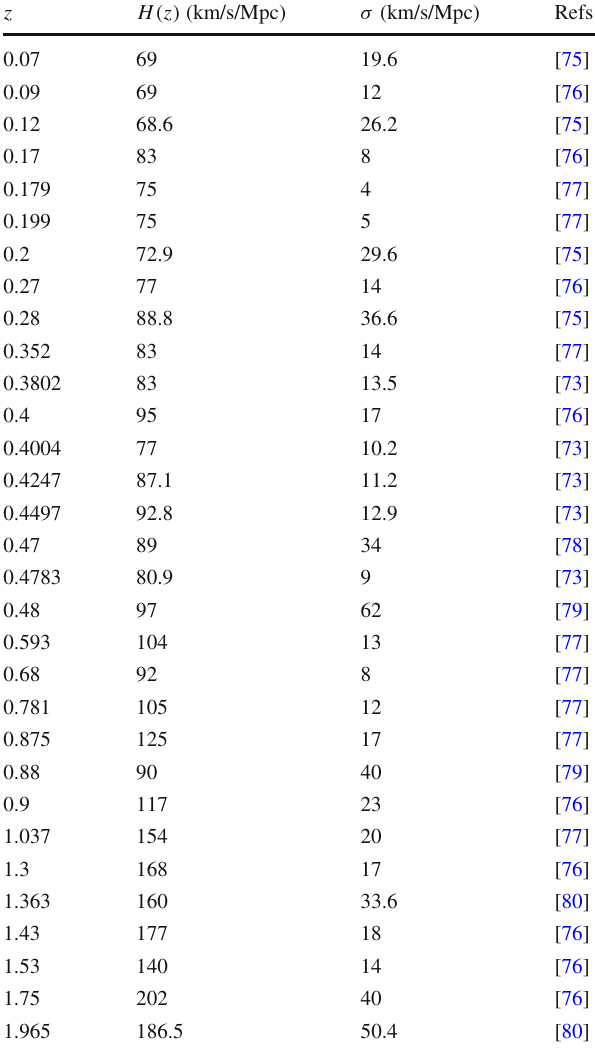
Table 1 H ( z ) data from cosmic chronometers along with references to original sources. This list was compiled from Ref.